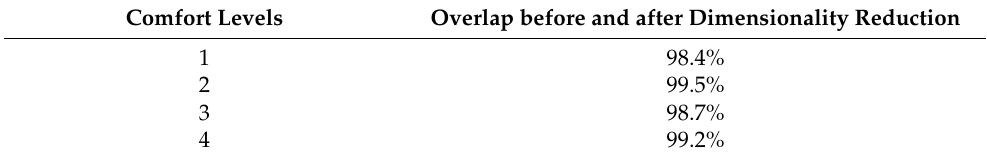
Table 8. Comparison of clustering results before and after dimensionality reduction. Comfort Levels Overlap before and after Dimensionality Reduction